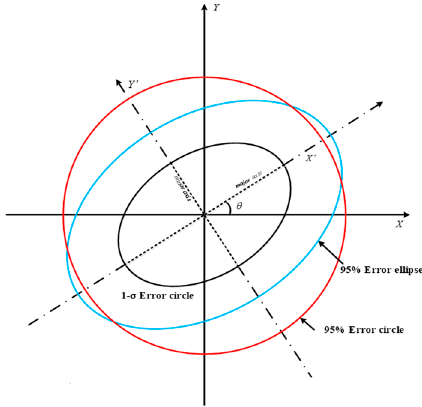
Figure 2. Two-dimensional ANP model.